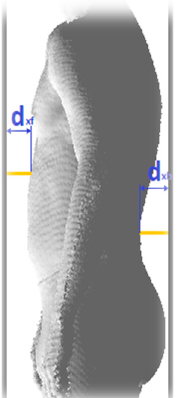
Figure 10. Scan with marked front and back face of bounding box and corresponding exemplary depth measurements.